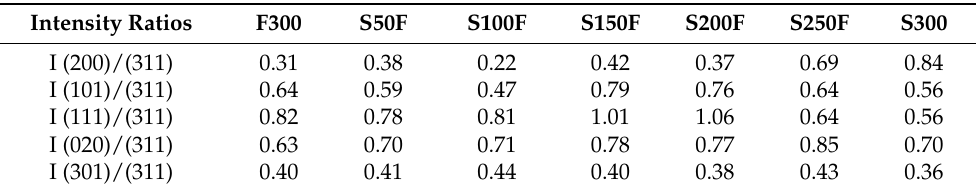
Table 5. Relative intensity ratios of the diffraction peaks in the XRD patterns of the synthe- sized LiFePO 4 . Intensity